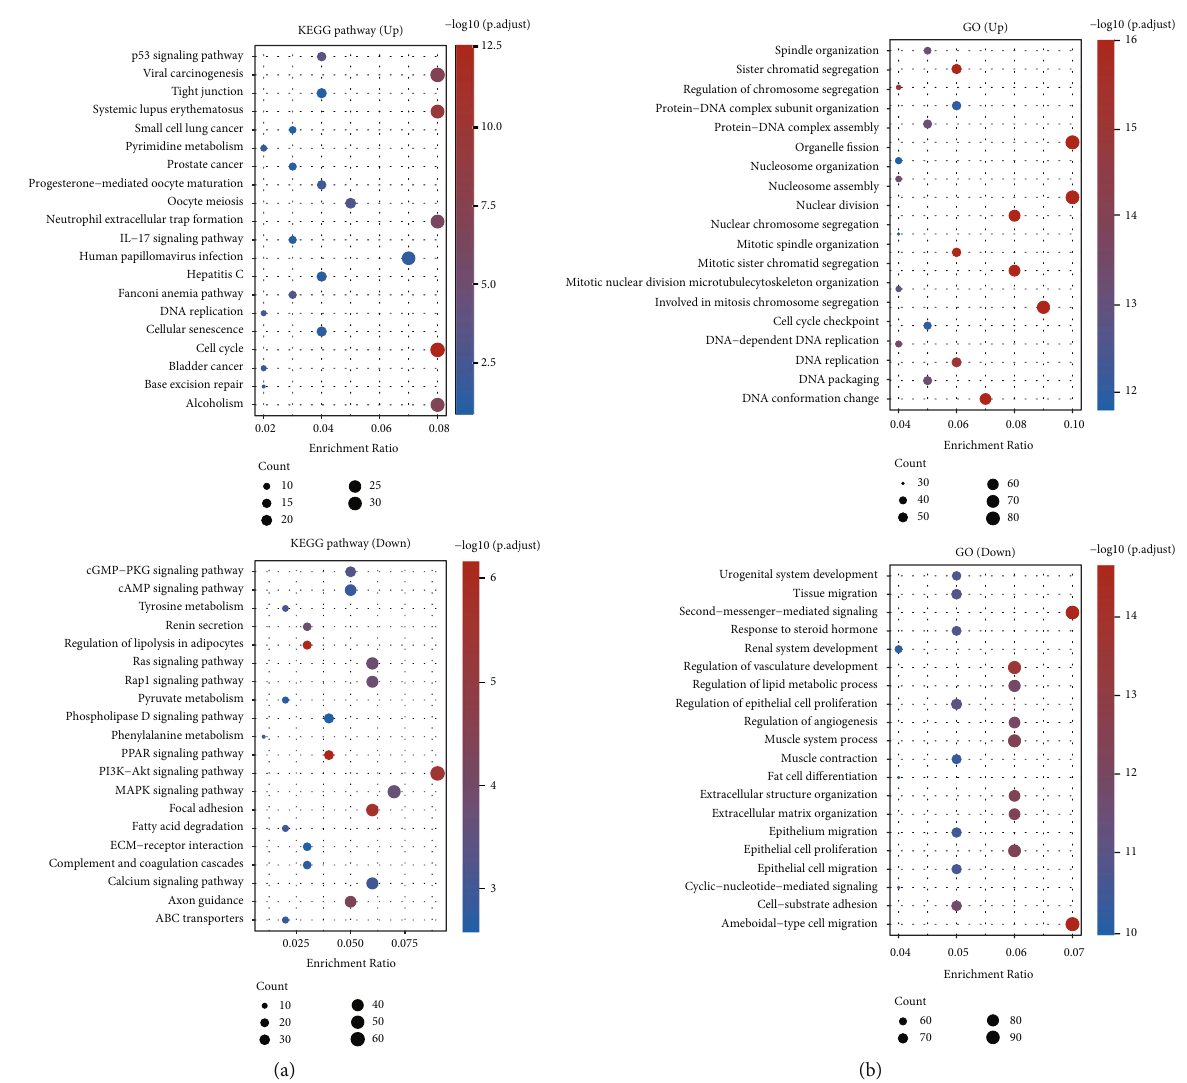
Figure 2: Functional enrichment analyses. (a) KEGG assays. (b) GO